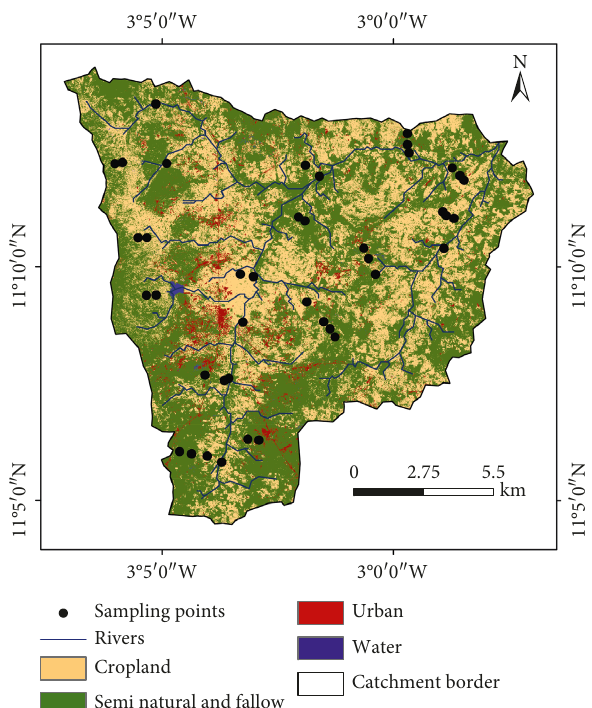
Figure 1: Location of sampling points within the Dano catchment. Each sampling point refers to two adjacent cropland and fallow plots. Land use map is after Forkour